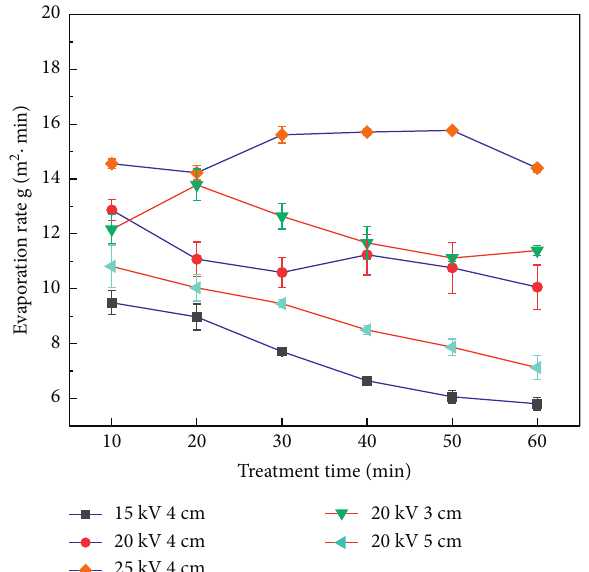
Figure 7: Evaporation rates at voltages of 15, 20, and 25kV and needle-dielectric plate distance of 4cm and voltage of 20kV and needle-dielectric plate distance of 3cm and